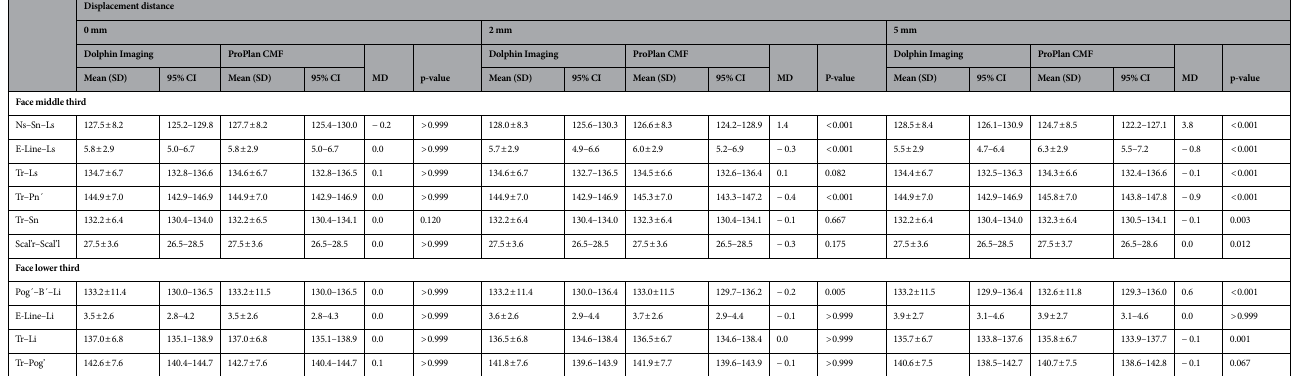
Table 5. Mean values, SDs and 95% confidence intervals of the angular and linear changes in the middle and lower third of the face after maxillary impaction simulation with the corresponding p values of the comparison between the outcome of the surgical planning programs Dolphin and ProPlan depending on different displacement distances. SD standard deviation, CI confidence interval, MD mean